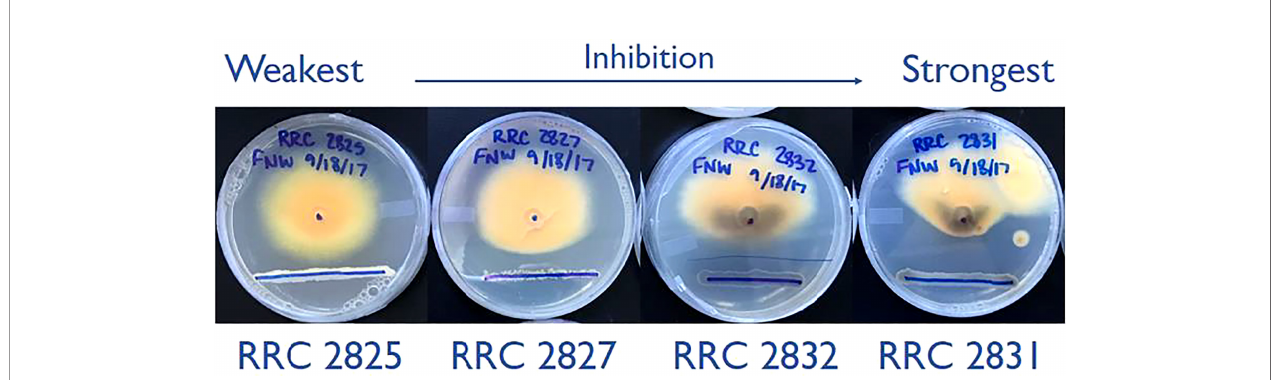
FIGURE 1 | Dual-culture inhibition assays of the four Streptomyces strains used in this study. Strains spanning the full range of inhibition phenotypes were selected from an initial 9 tested. The lower blue sharpy lines indicate the locations of Streptomyces strain inoculation, grown for two days before inoculation of F. verticillioides . The central dot (25mm from the line) indicates where F. verticillioides spores were inoculated. Images captured 7 days after fungal spore